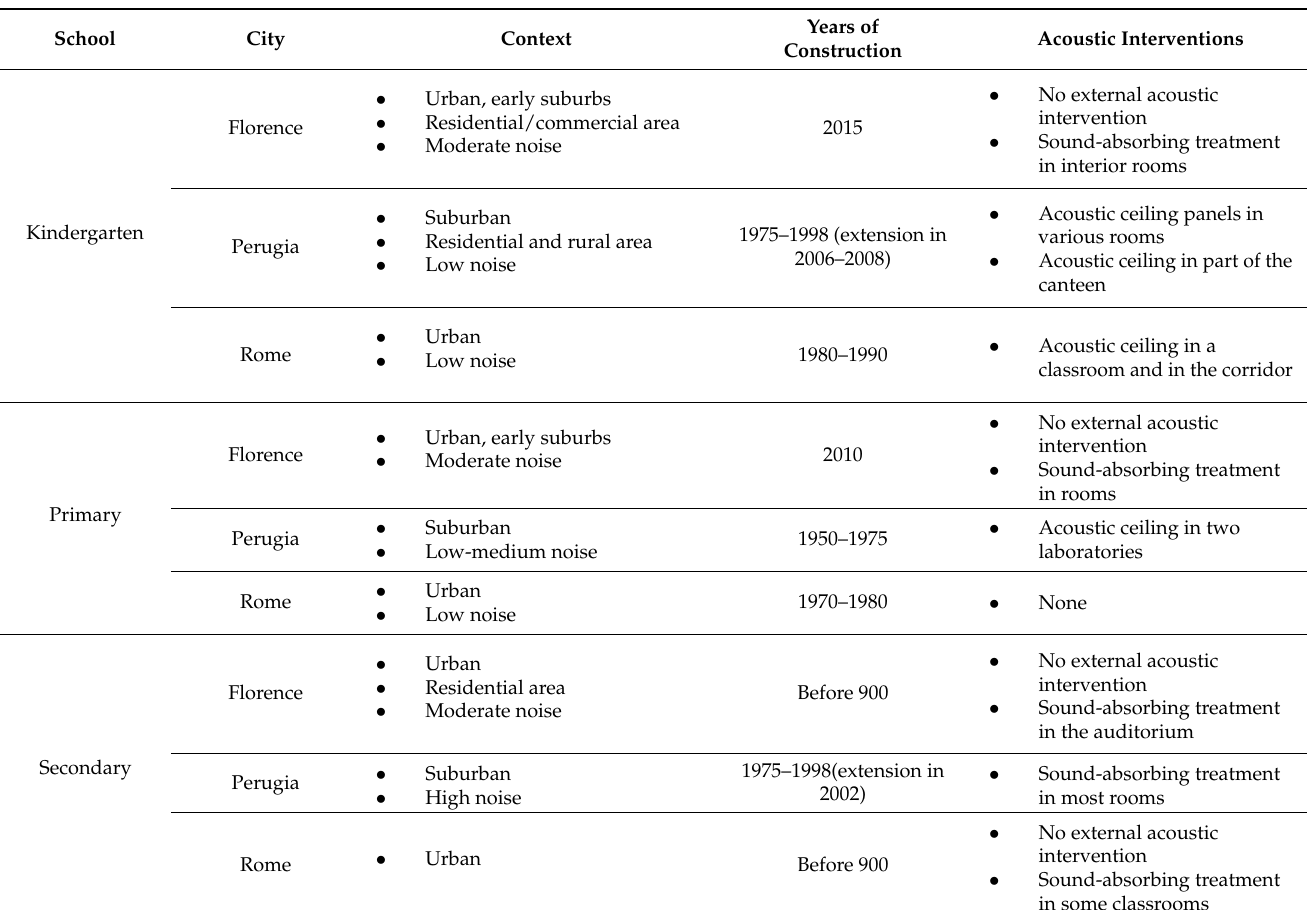
Table 2. The description of the selected case